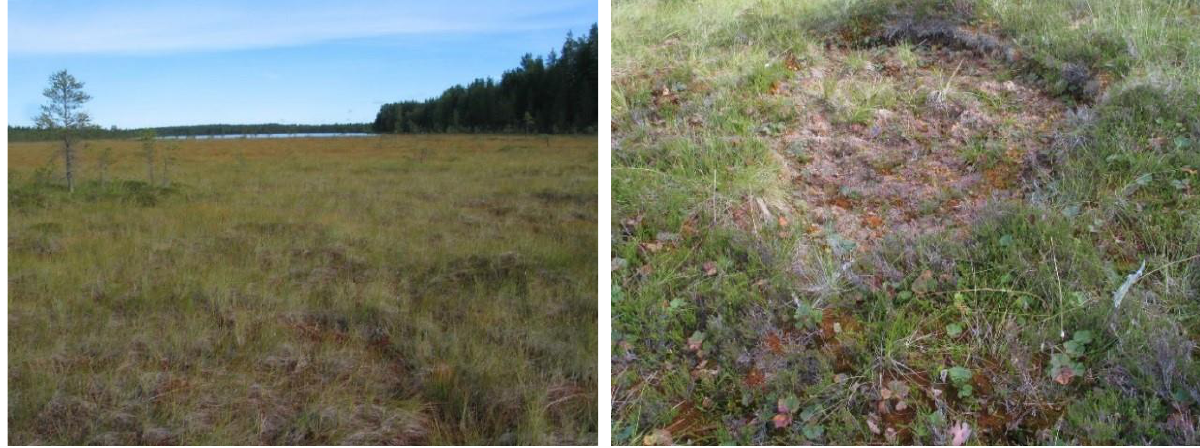
Figure 1. Neva-Lyly, a typical sparsely drained raised bog in Finland. An intact Sphagnum surface can be seen on the left, and a surface harvested three years previously on the